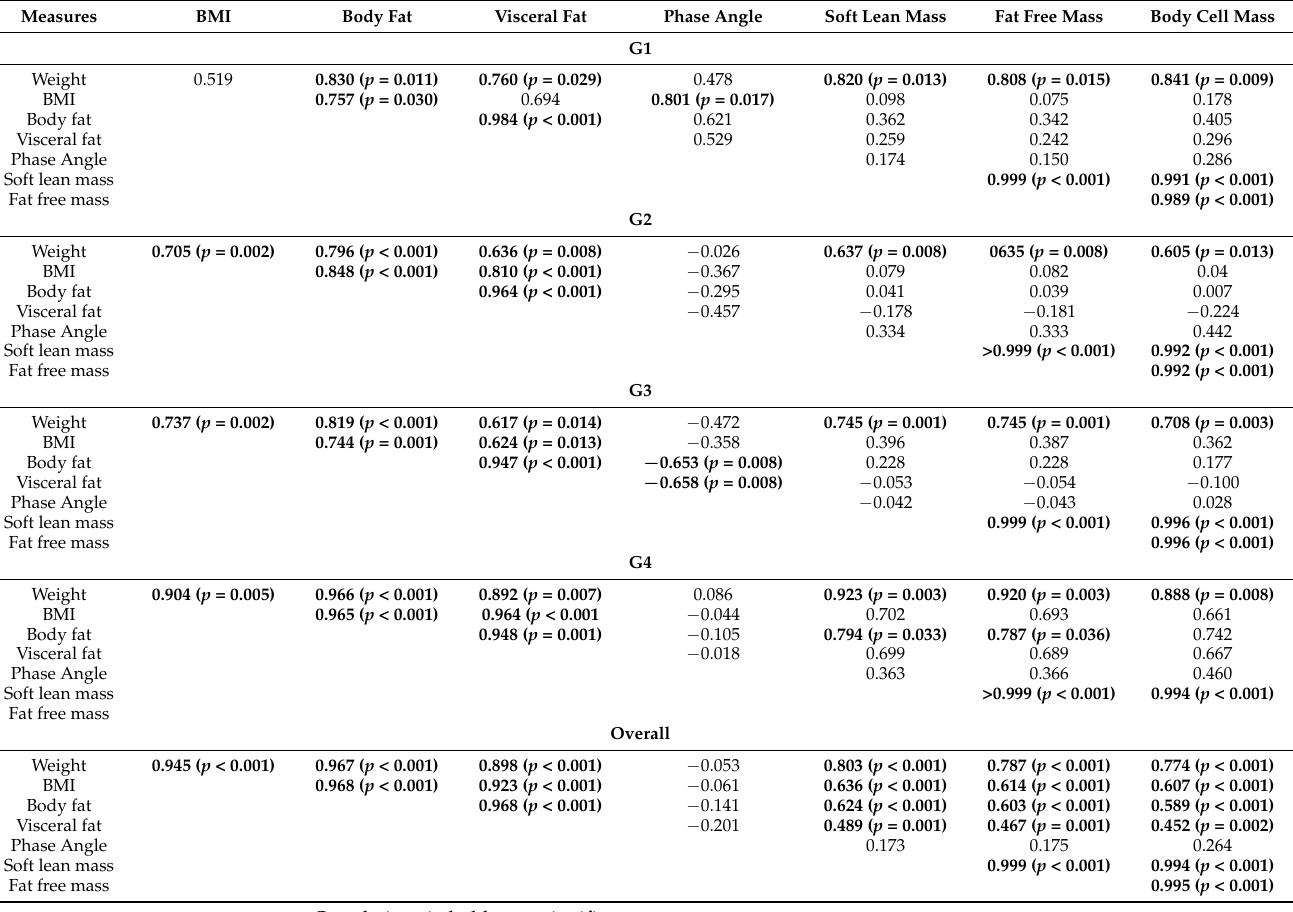
Table 2. Correlation analysis between weight, BMI and body composition variables for each group and overall sample.